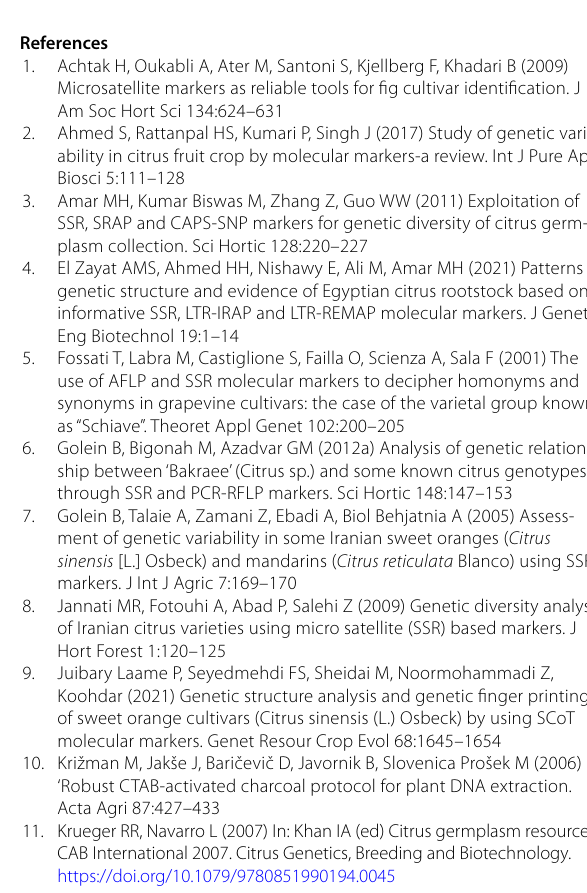
Additional file 1: Table S1 . AMOVA table based on SSR alleles for 13 cultivars. Table S2 . Pairwise groups Fst value between cultivars. Fig. S1 . Allele patterns of CAC15 SSR locus. 50bps Ladder. Fig. S2 . Allele patterns of TAA27 SSR locus. 50bps